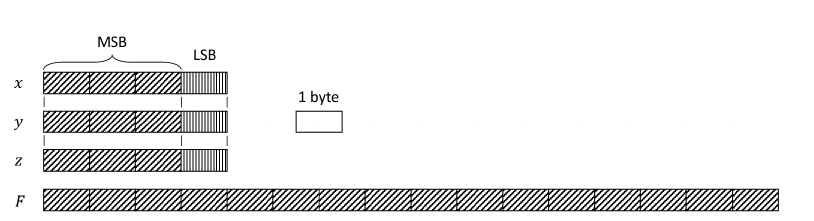
Figure 2. The fields and structure of an Embedding Unit